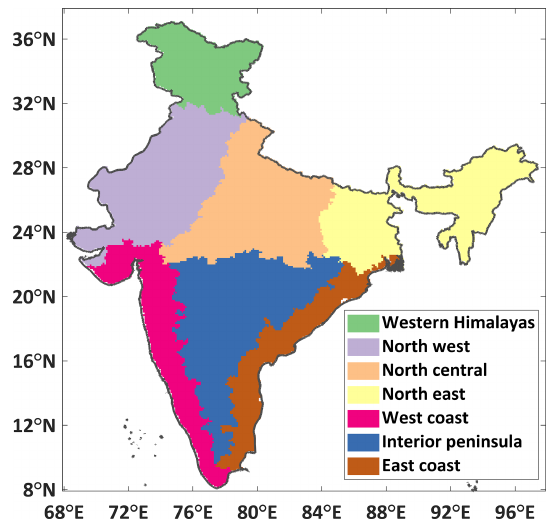
Figure 1. Homogenous regions of